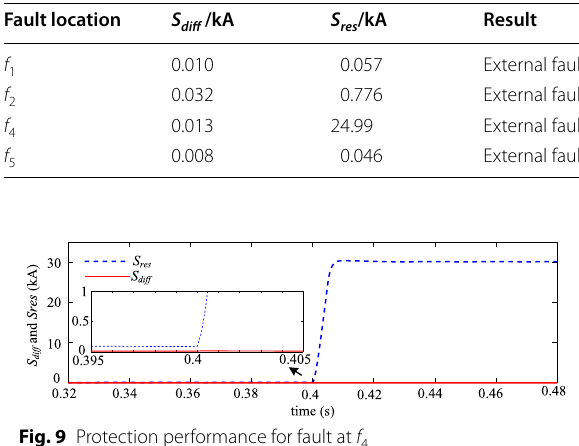
N for three-phase short-circuit 3 4